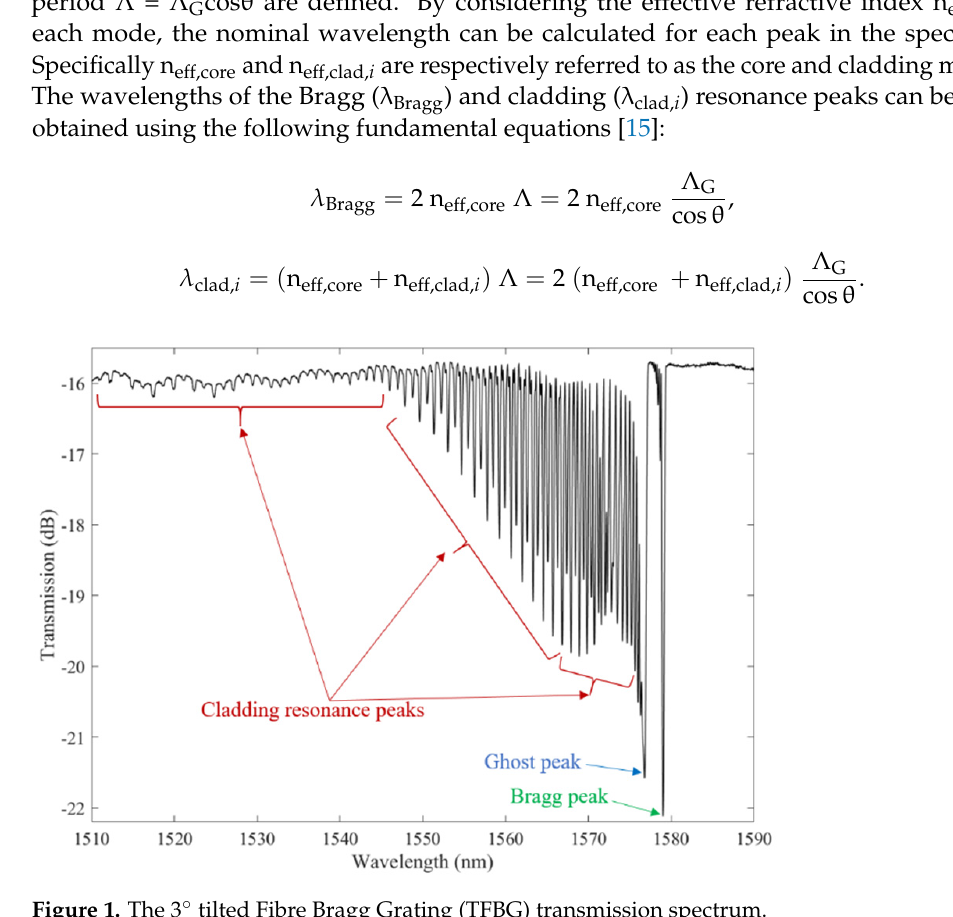
Figure 1. The 3° tilted Fibre Bragg Grating (TFBG) transmission spectrum. Figure 1. The 3 ◦ tilted Fibre Bragg Grating (TFBG) transmission